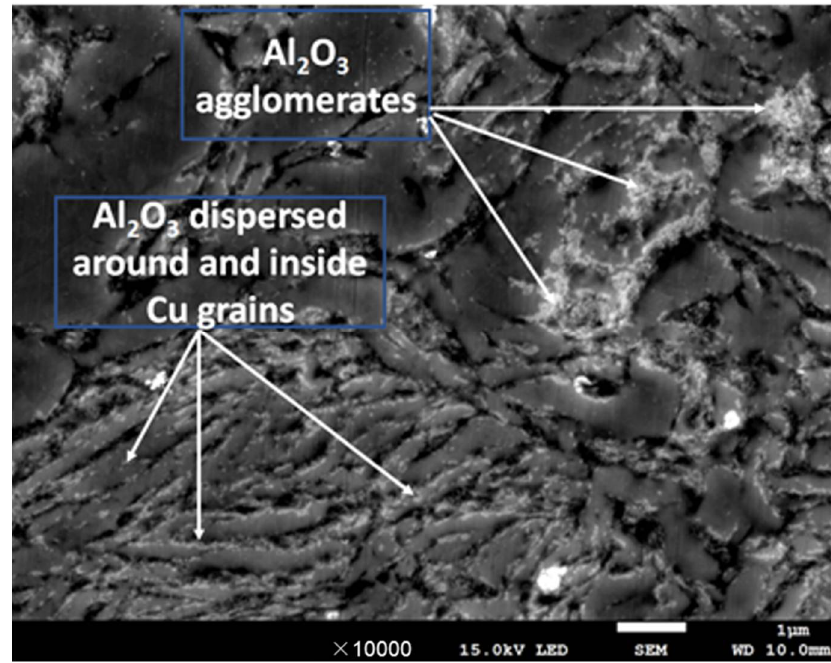
Figure 13. SEM showing alumina distribution behavior in the Cu matrix.